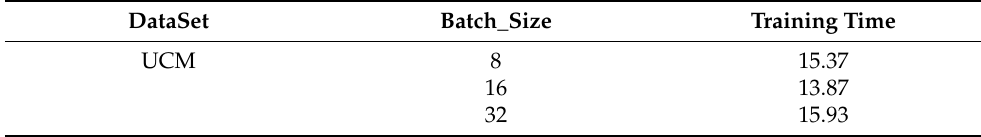
Table 5. Training time of DFEN with different batche_size in UCM-caption